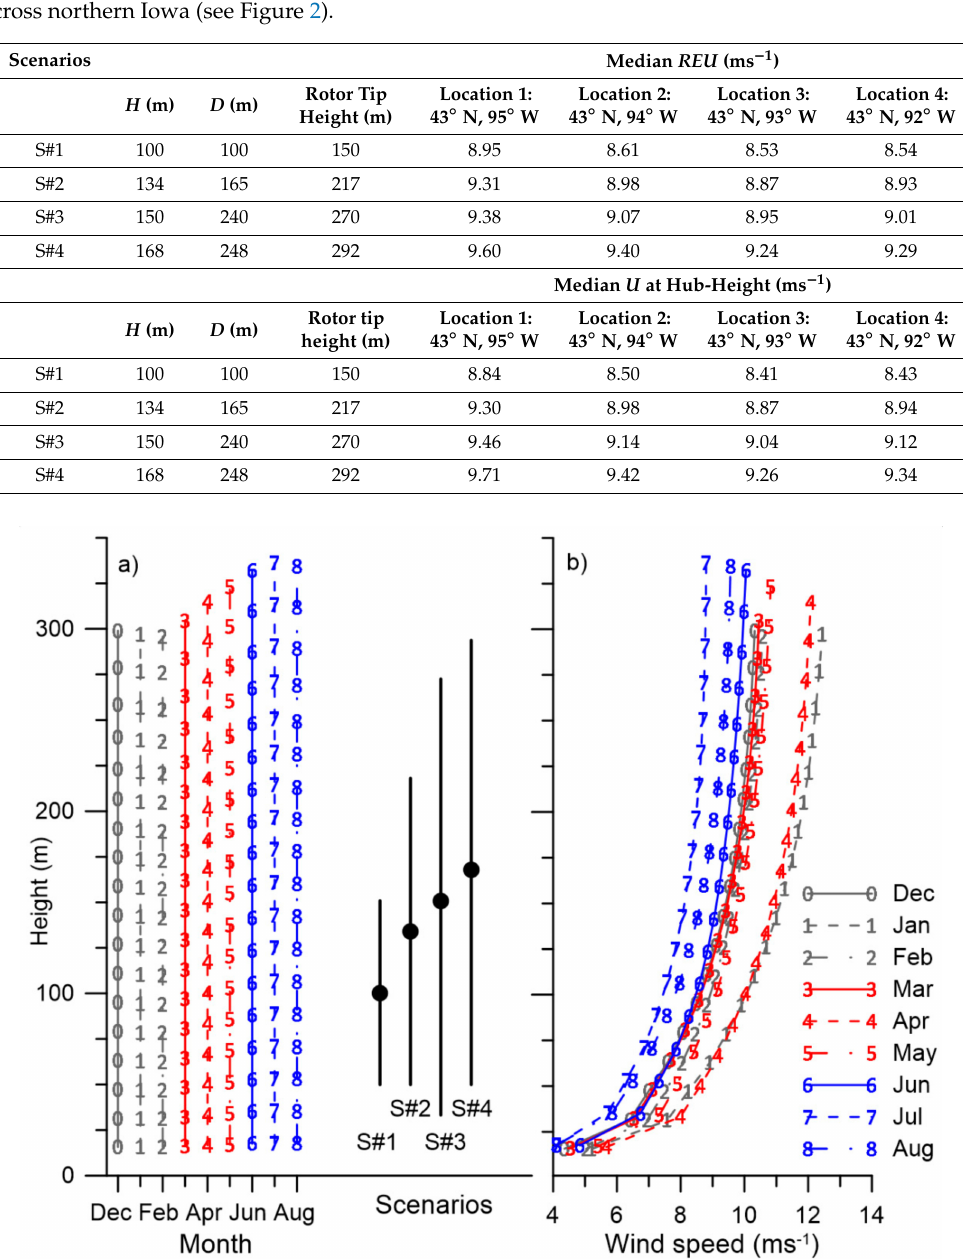
Figure 3. ( a ) Mean model levels (shown by the numbers) in the WRF output for each calendar month derived from the modeled sigma coordinate system. The solid black lines show the hub-height and top and bottom of the rotor plane for each of the four WT scenarios, S#x (i.e., variations of H and D , see Table 1). ( b ) Mean wind speed profile at site 1: 43 ◦ N, 95 ◦ W, in each calendar month computed using 10-min output from the lowest 18 model levels where the numbers depict the mean height